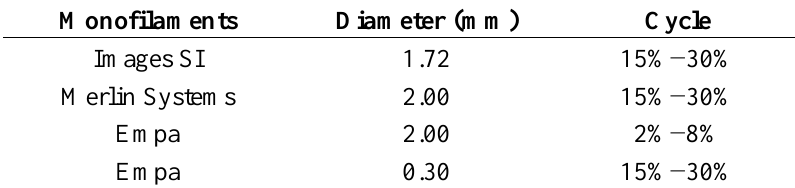
Table 2. Listing of tensile and cyclic strain tests for the different monofilament types and their nominal expected thicknesses. Due to their low failure strain, the 2 mm Empa monofilaments were only cycled between 2% and 8% strain due their lower failure